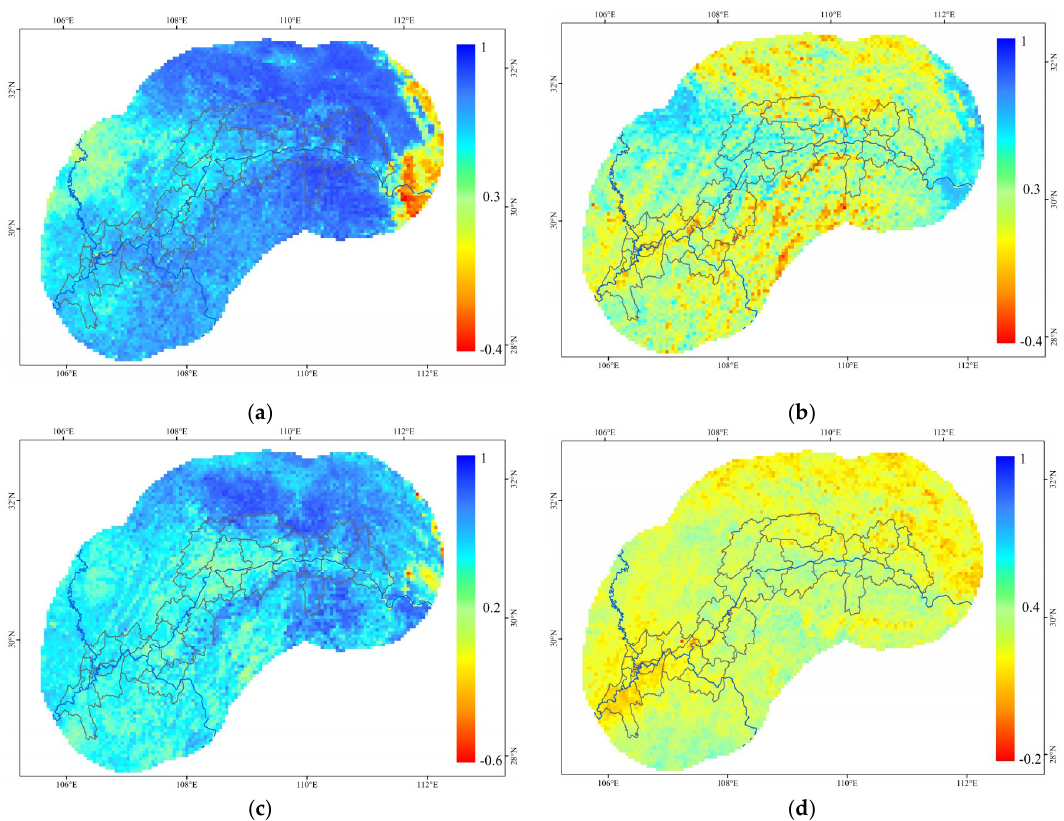
Figure 6. Partial correlation coefficient of NDVI–temperature in four seasons: ( a ) spring; ( b ) summer; ( c ) autumn; and ( d ) winter.